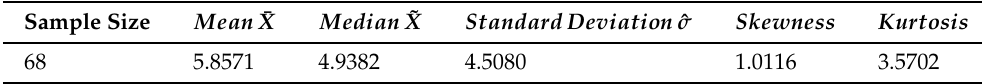
Table 11. Theoretical statistical measures from SBXL for